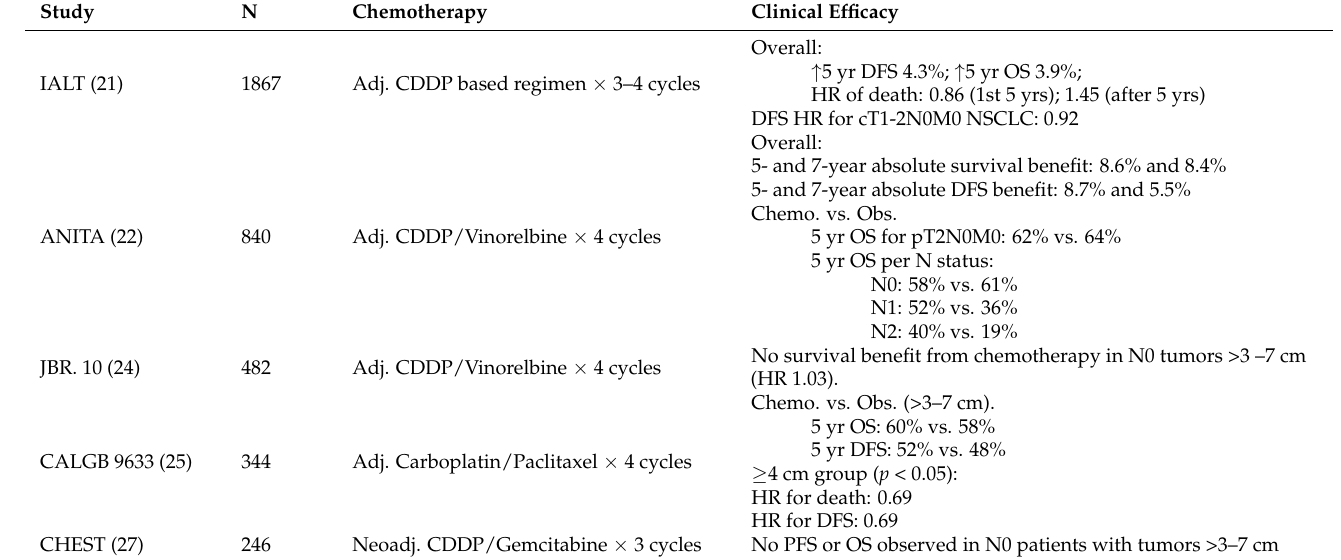
Table 2. Marginal benefits from adjuvant or neoadjuvant chemotherapy for ES NSCLC in randomized